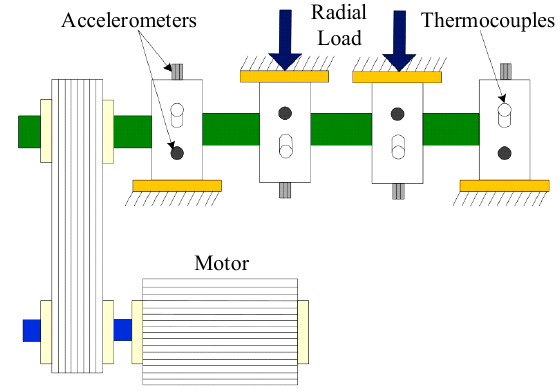
Figure 7. Structural diagram of the bearing test bench.